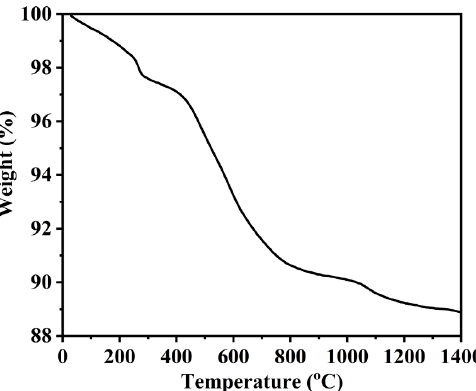
Figure 1. Thermogravimetric (TG) curve of crosslinked polycarbosilane (PCS).